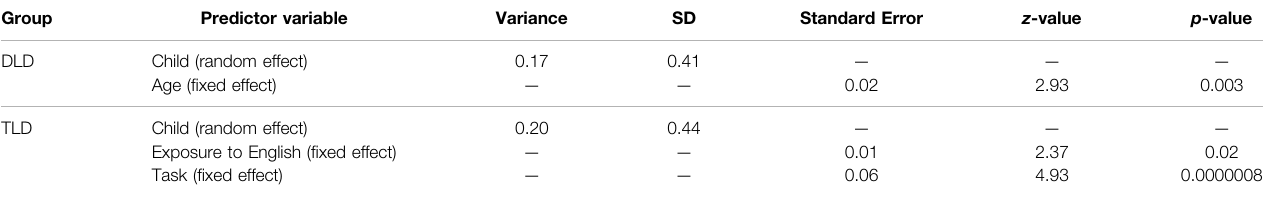
TABLE 8 | Logistic regression results examining individual differences in complex syntax use with one model for L2-DLD and one model for L2-TD where the outcome variable was a binary variable (simple or complex sentence).